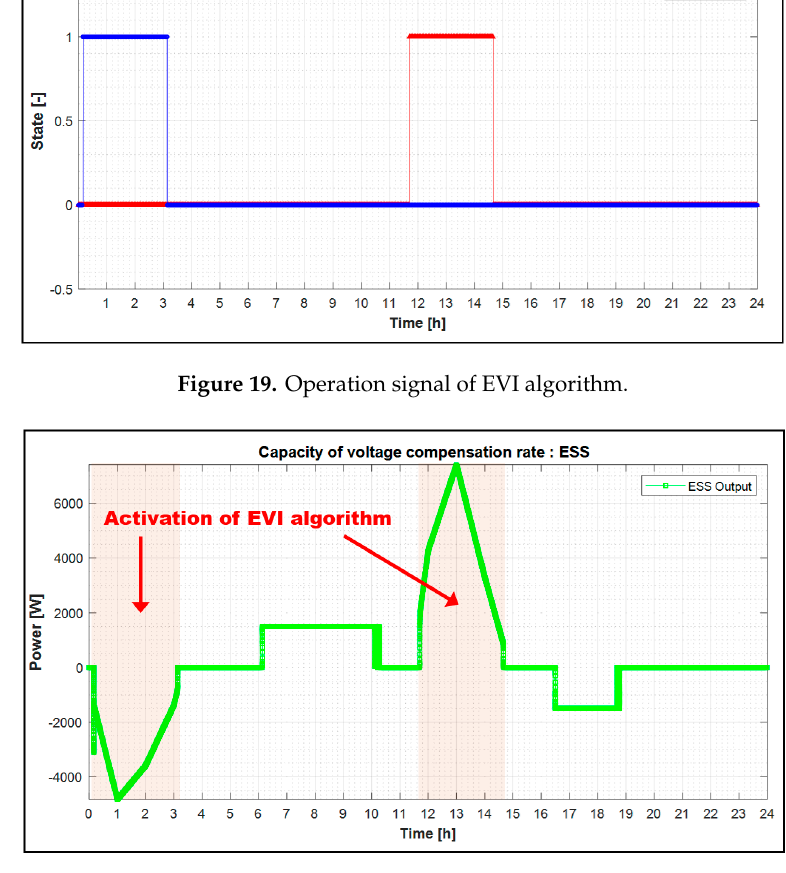
Figure 20. Capacity of voltage compensation rate for voltage stabilization.